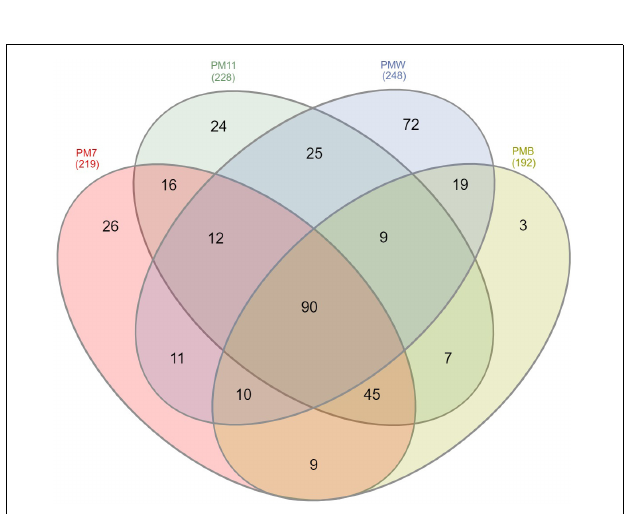
FIGURE 6 | Venn diagram showing the number of shared and unique 16S rRNA-related ASVs in the sediment (PM7 and PM11) and crust (PMW and PMB) samples of Muierilor Cave.